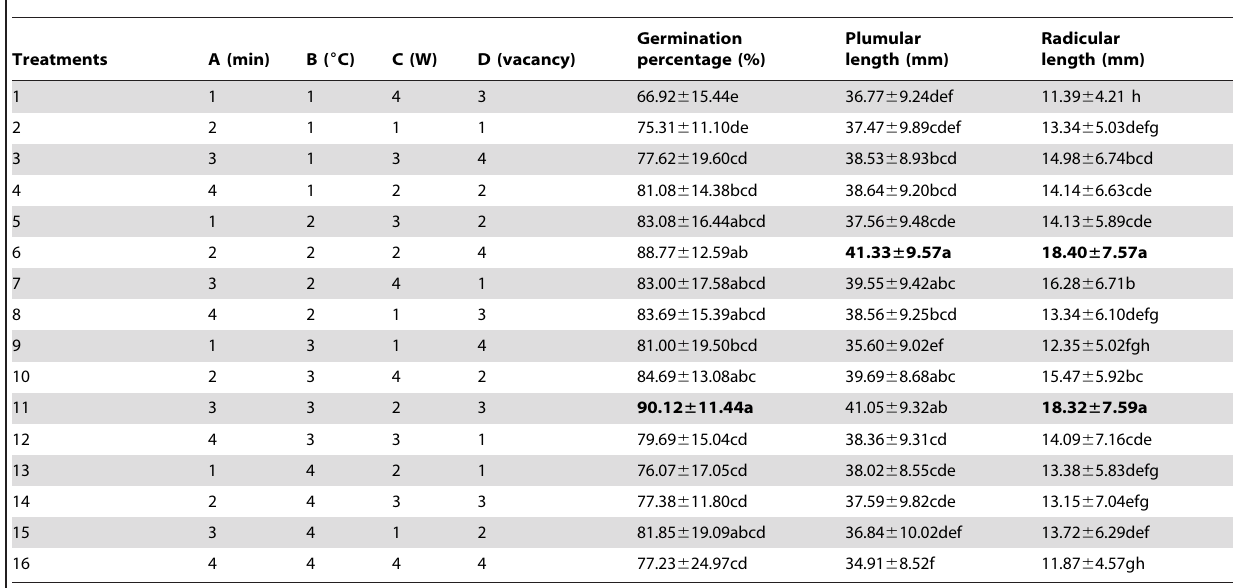
Values are the means 6 S.D. of the experiments. Means with the same lower letters are not significantly different at P , 0.05. The experiment was calculated for three replicates. The first experiment consisted of four subsamples (16 6 4 dishes in all); The second and third experiments consisted of three subsamples, respectively (16 6 3 6 2 6 2 dishes in all). The total samples of GP were 160. Each subsample of PL and RL was respectively calculated for ten seeds. PL and RL of 2560 seeds (16 6 4 6 10 + 16 6 3 6 2 6 2 6 10) were respectively measured. The highest values of GP, PL and RL are highlighted in bold for the 16